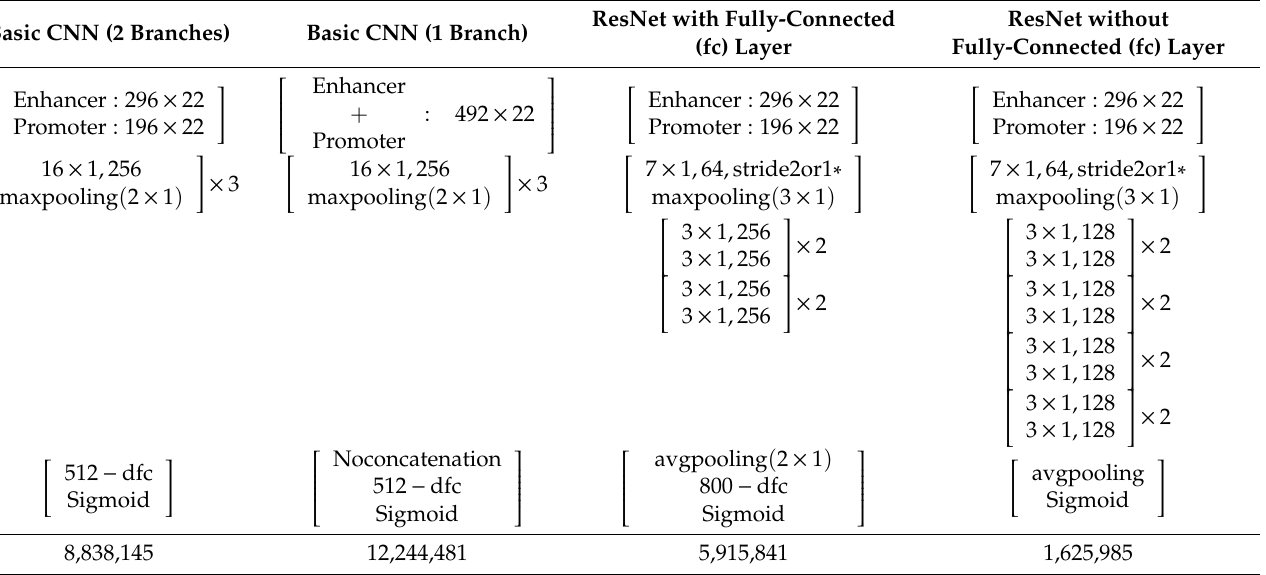
Table 3. Epigenomic model